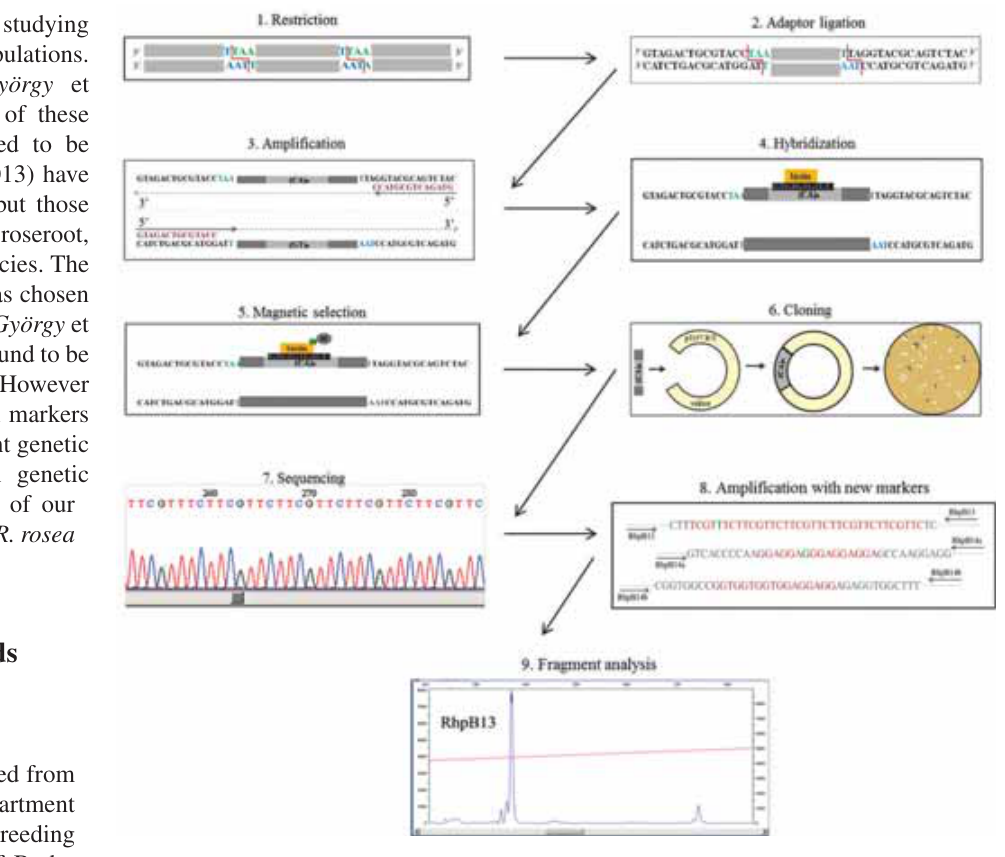
sample was cleaved with Tru1 I restriction endonuclease.